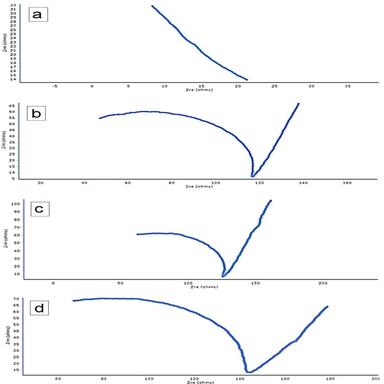
a) Bare Ti Nyquist plot of time to indulge in Hank's solution; b) CS/ZnONyquist plot on Ti of time to indulge in Hank's solution; 3c) CS/ZnO, Ag Nyquist plot on Ti of time to indulge in Hank's solution; d) CS/ZnO, Au Nyquist plot on Ti of time to indulge in Hank's solution.